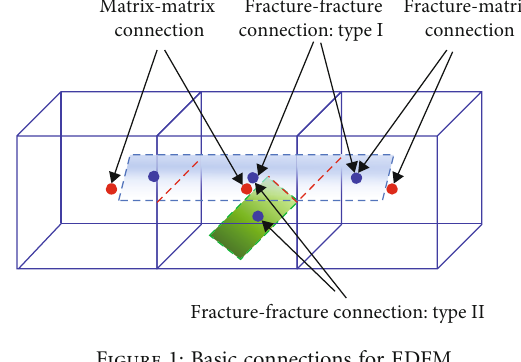
Figure 1: Basic connections for EDFM.